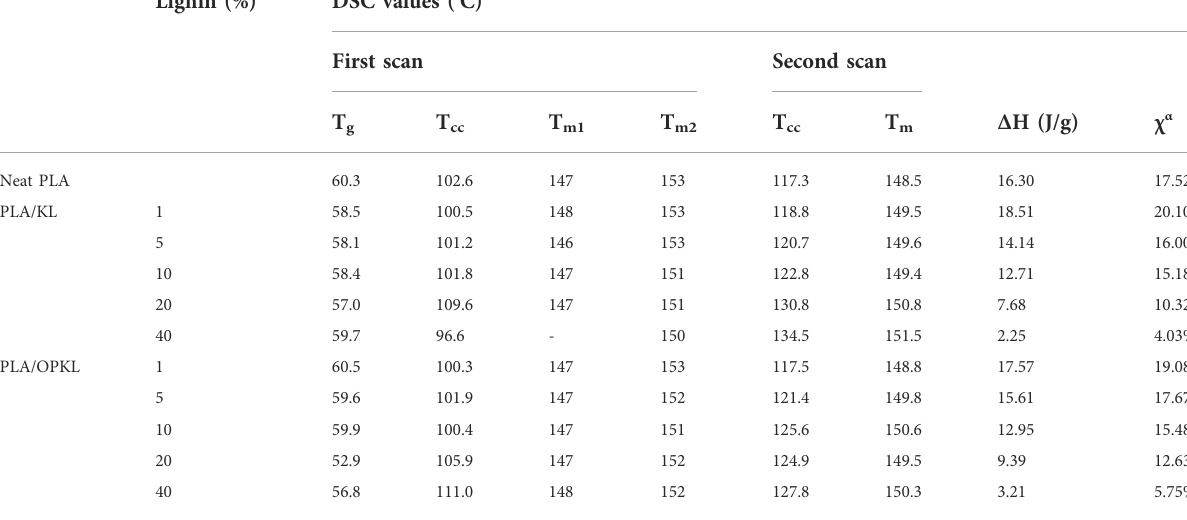
TABLE 2 DSC parameter values of neat PLA, PLA/KL and PLA/OPKL composites: T g — glass transition temperature, T cc — cold crystallization temperature and T m1 and T m2 — melting temperatures from fi rst heating scan. Lignin